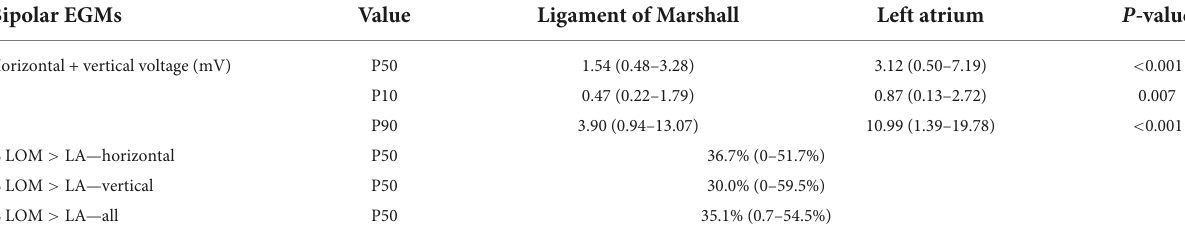
TABLE 3 Characteristics of bipolar